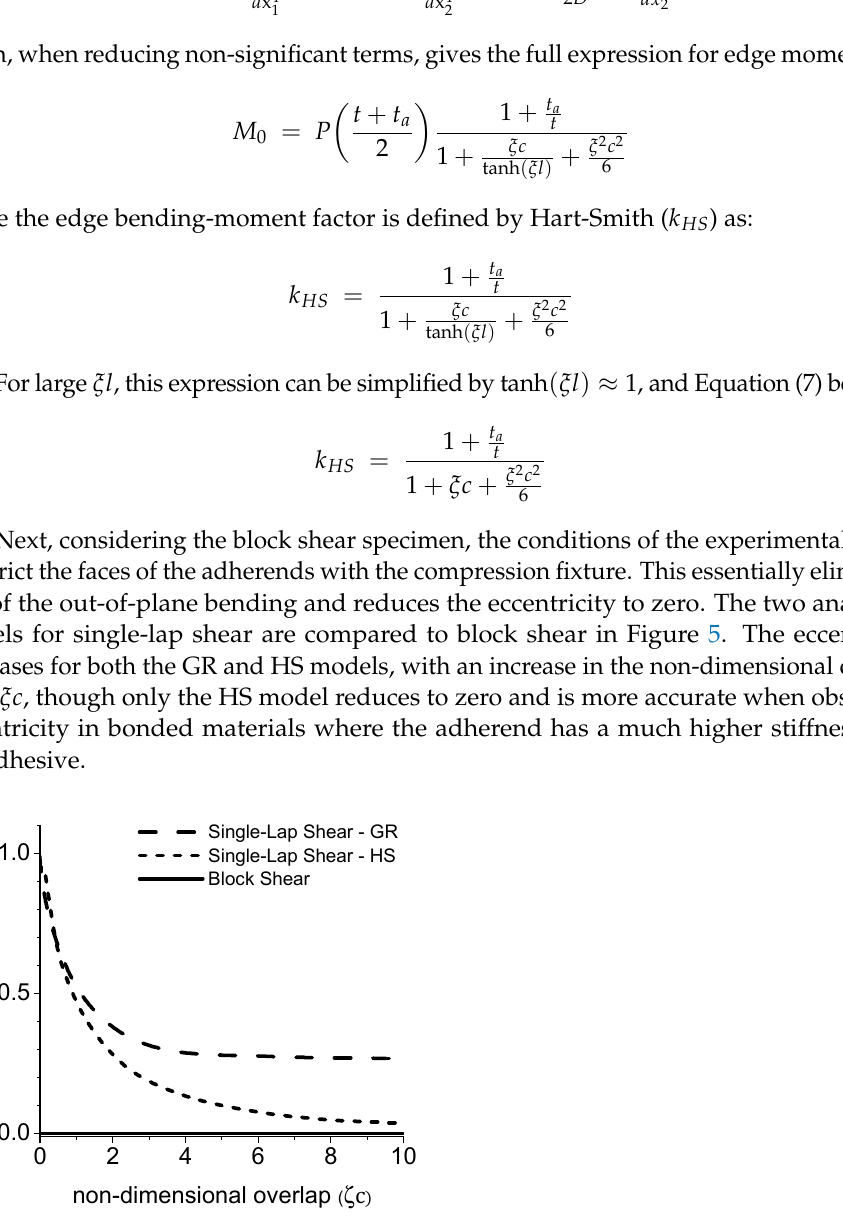
Figure 5. Edge bending-moment factor k for single-lap shear geometry as determined by Goland and Reissner (GR) and Hart-Smith (HS) compared to block shear.